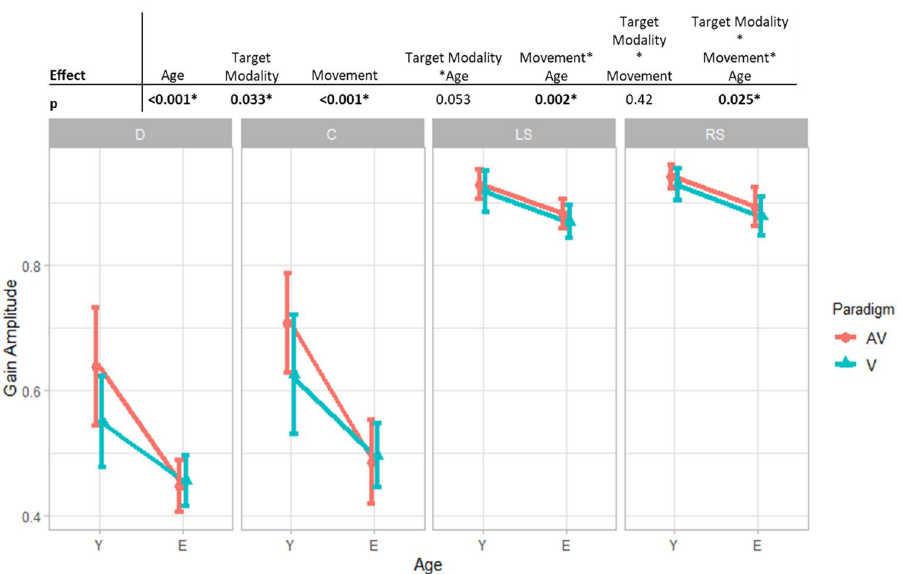
Figure 3. Summary of the main and interaction effects of the 3-ways ANOVA with repeated measures for gain amplitude. Gain amplitude means and 0.95 confidence intervals in function of movement (D for divergence, C for convergence, LS for left saccade, RS for right saccade), age group (Y for young group, E for elderly group) and modality target (AV for audiovisual target, V for visual